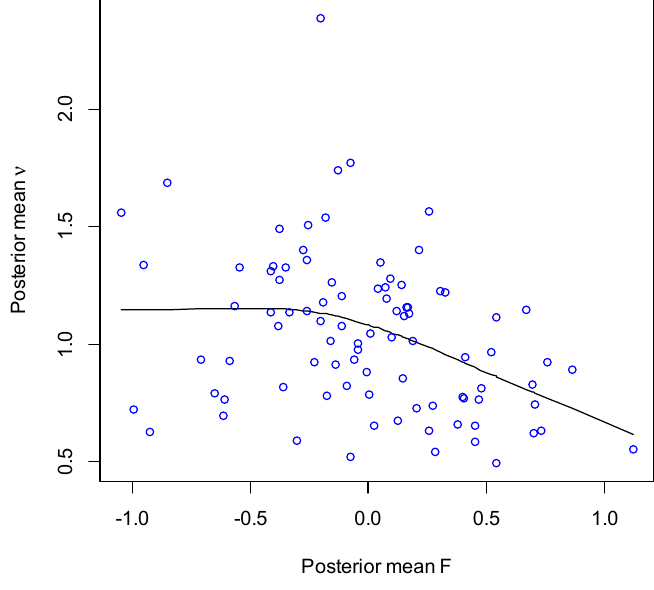
Figure 1. Quality of care and emergency admission relative risk.